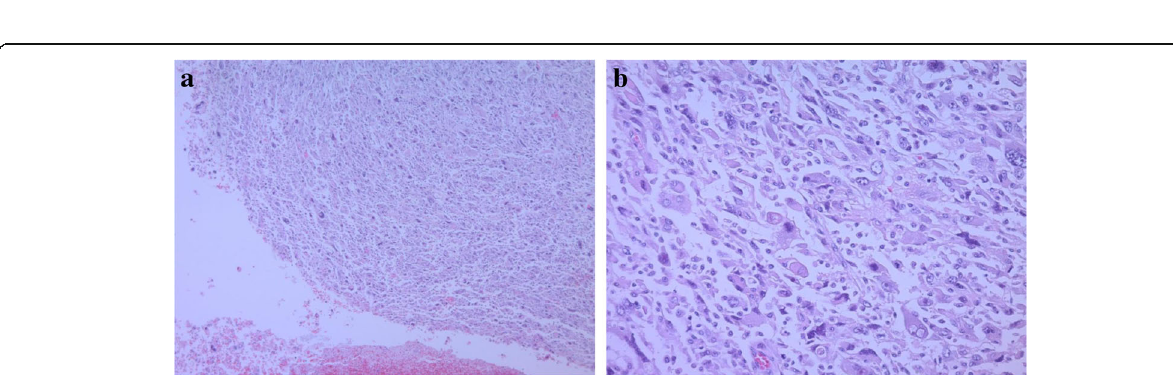
Fig. 6 Histopathological findings. The spindle ‑ shaped cells with nuclear atypia and eosinophilic cytoplasm proliferated diffusely. The tumor cells were full of pleomorphism. a : Hematoxylin-Eosin staining, ×50 b : Hematoxylin-Eosin staining, ×200